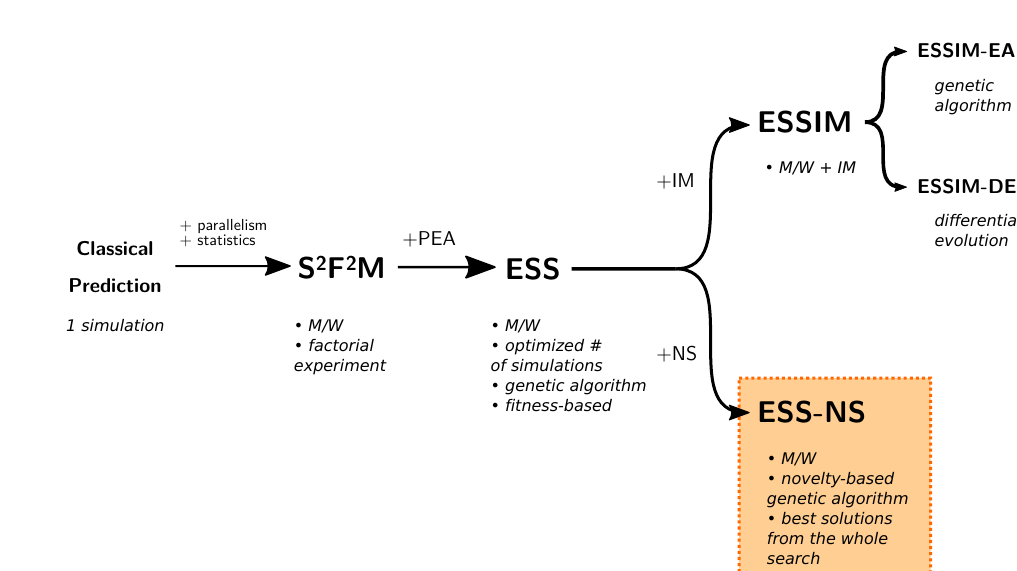
Figure 1. Taxonomy of wildfire spread prediction methods. S 2 F 2 M : Statistical System for Forest Fire Management, ESS : Evolutionary Statistical System, ESSIM : ESS with Island Model, ESSIM-EA : ESSIM based on Evolutionary Algorithms, ESSIM-DE : ESSIM based on Differential Evolution, ESS- NS : ESS based on Novelty Search, M/W : Master/Worker parallelism, PEA : Parallel Evolutionary Algorithm, IM : Island Model, NS : Novelty Search.